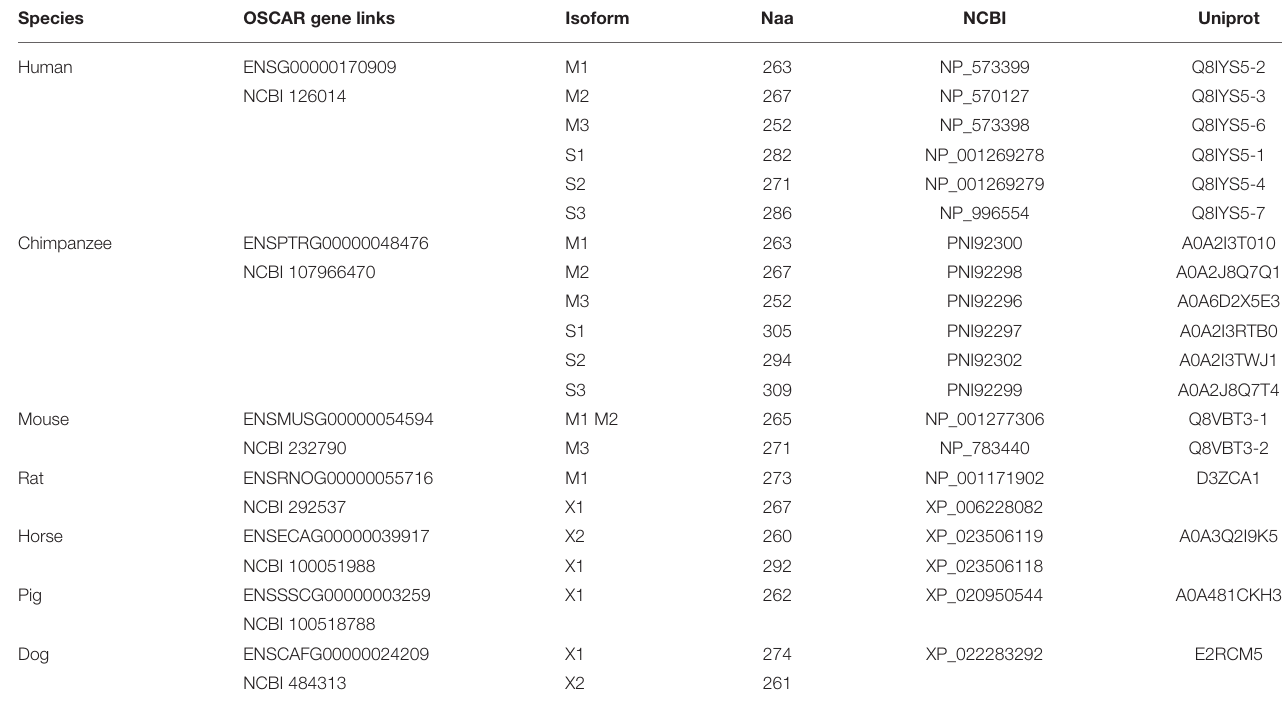
TABLE 2 | Representative entries for OSCAR genes and currently described or predicted isoforms in genome databases. Species